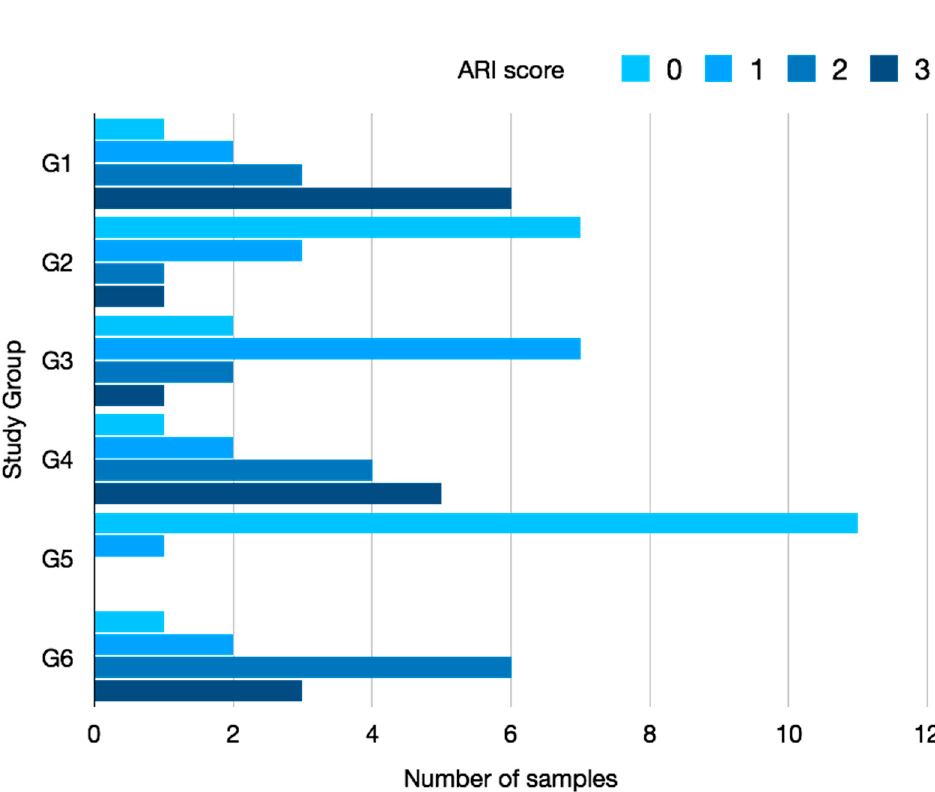
Figure 4. Mean of bonding technique interactions according to the levels of the factors material and bonding technique.